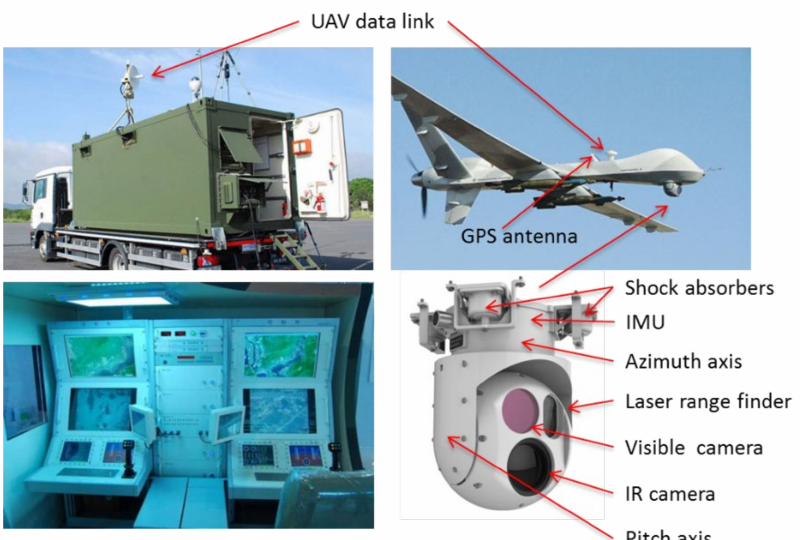
Figure 1. The geo-location system introduced in this article (The top left figure shows the ground control station and the figure on the bottom left shows the inside of the station; the top right figure shows the UAV with the airborne optoelectronic platform, and the bottom right figure shows the detail of the airborne optoelectronic